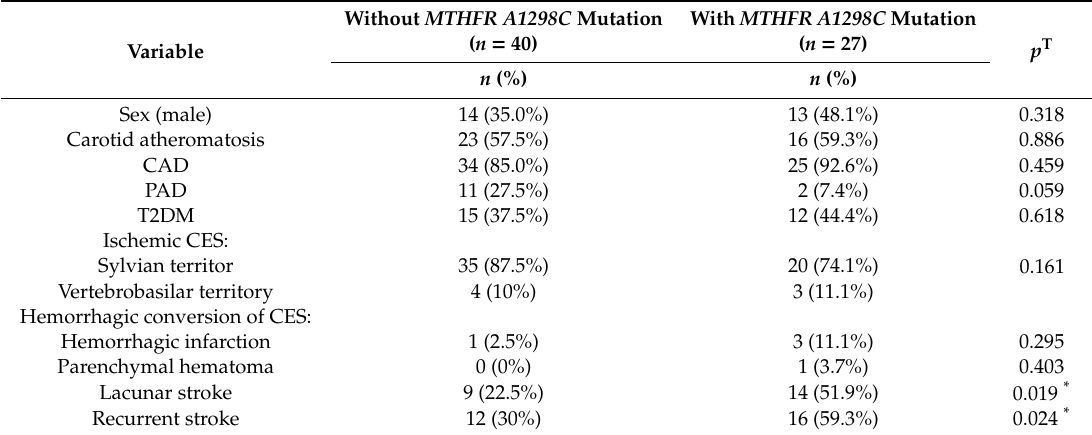
Table 4. Comparisons of proportions of cardiovascular comorbidities and stroke localization for MTHFR A1298C mutation ( n = 67) using the Chi 2 Test.